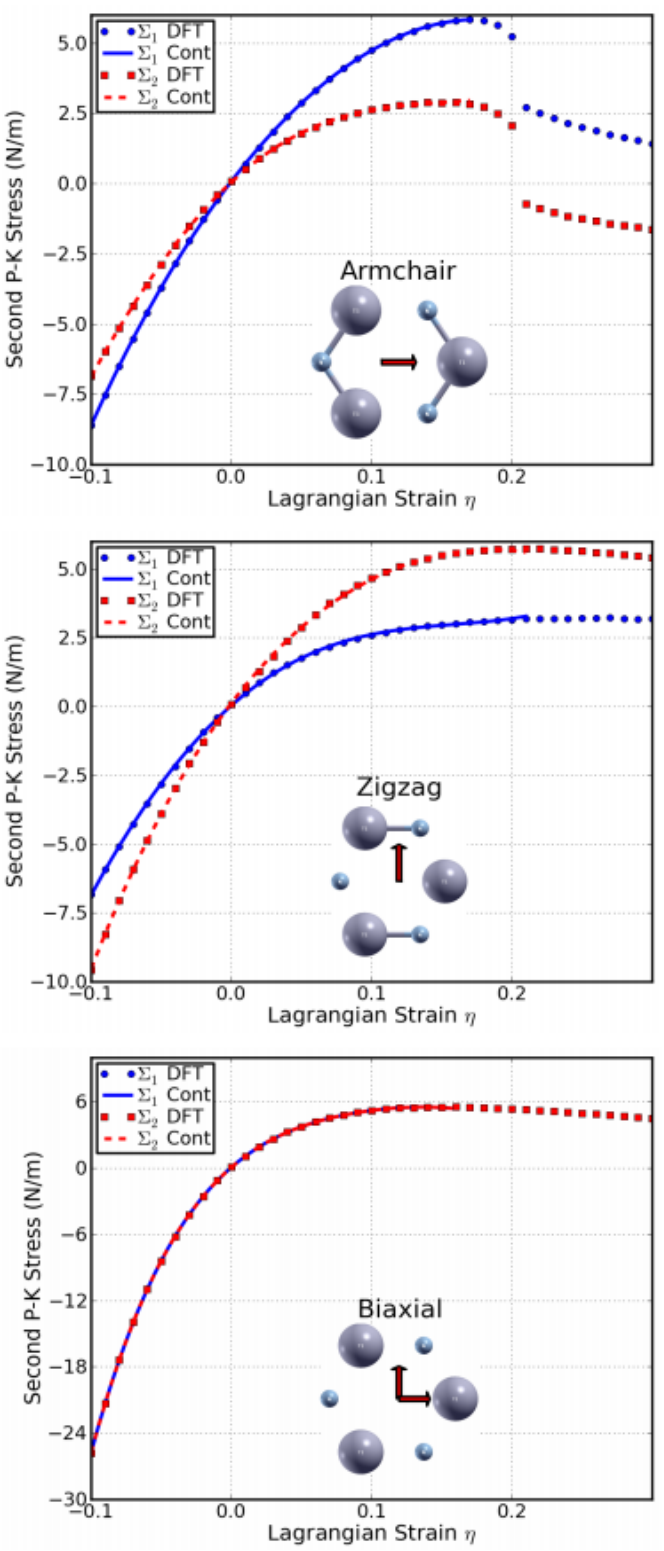
Figure 23. Stress–strain responses of g -TlN under the armchair ( top ), zigzag ( middle ), and biaxial ( bottom ) strains. Σ 1 ( Σ 2 ) denotes the x ( y ) component of stress. “Cont” stands for the fitting of DFT calculations (“DFT”) to continuum elastic theory.